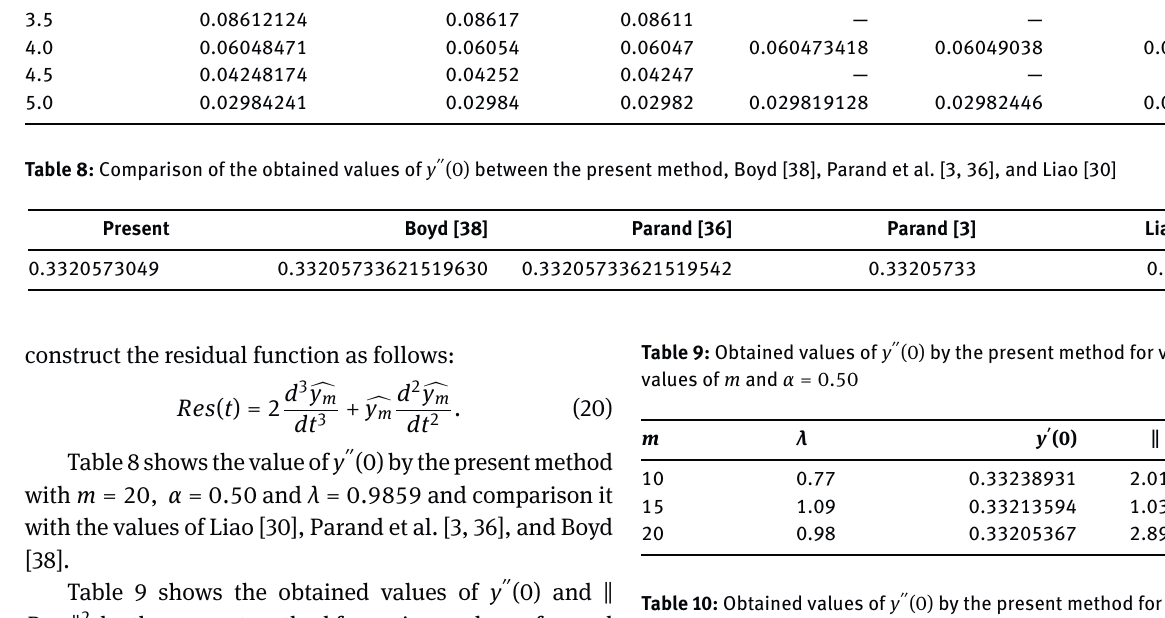
Table 10: Obtained values of y ′′ (0) by the present method for vari- ous values of α and m =